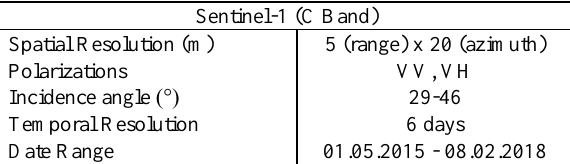
Table 1. Properties of Sentinel-1 images